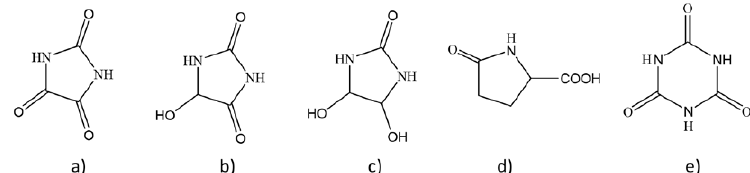
Figure 6. The formation tentatively involves the condensation reaction of urea and glyoxal, hydrated glyoxal or oxalic acid as a reactant. Imidazo- line-2,4,5-trione (a) 5-hydroxy-2,4-imidazolidindione (b), 4,5-dihydroxy-2-imidazolidinone (c), 5-oxo-proline (d) and cyanuric acid (e) as a side reaction of urea thermolytic decomposition were also detected.